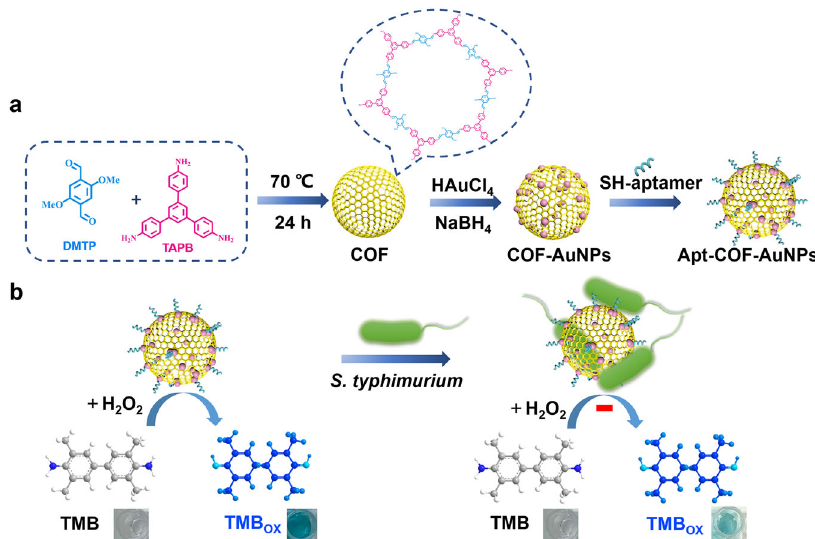
Fig. 1 Schematic representation of the assay for detection of S. typhimurium . a The preparation technology for apt-COF-AuNPs and b Colorimetric detection of S. typhimurium . S. typhimurium -inhibited peroxidase activity of apt-COF-AuNPs slowed down the oxidation of TMB with H 2 O 2 , giving the samples a lighter blue color. All images created by